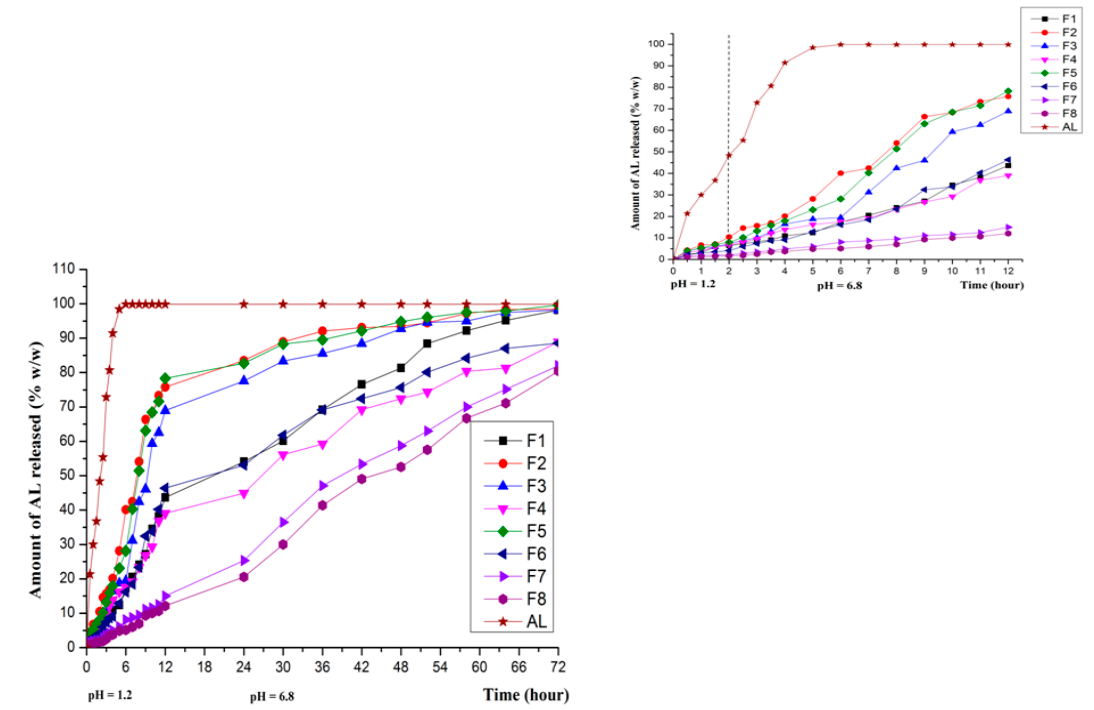
Figure 8. In vitro dissolution release of AL in simulated gastrointestinal fluids (left—72 h; right—the first 12 h) .